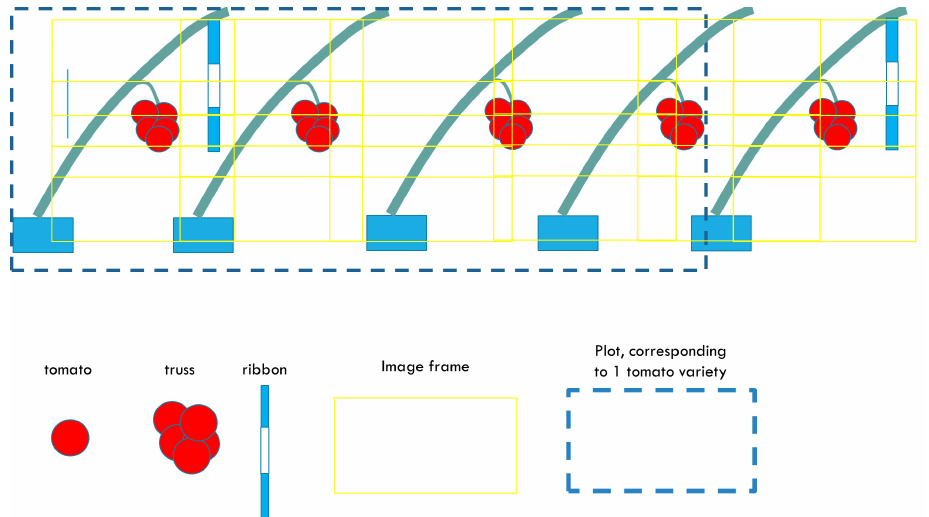
Figure 3. A stylized representation of the elements necessary to process image-level data to create plot-level yield predictions. The blue-white ribbon indicates the start of a plot containing four plants. The image boundaries for each camera are shown in